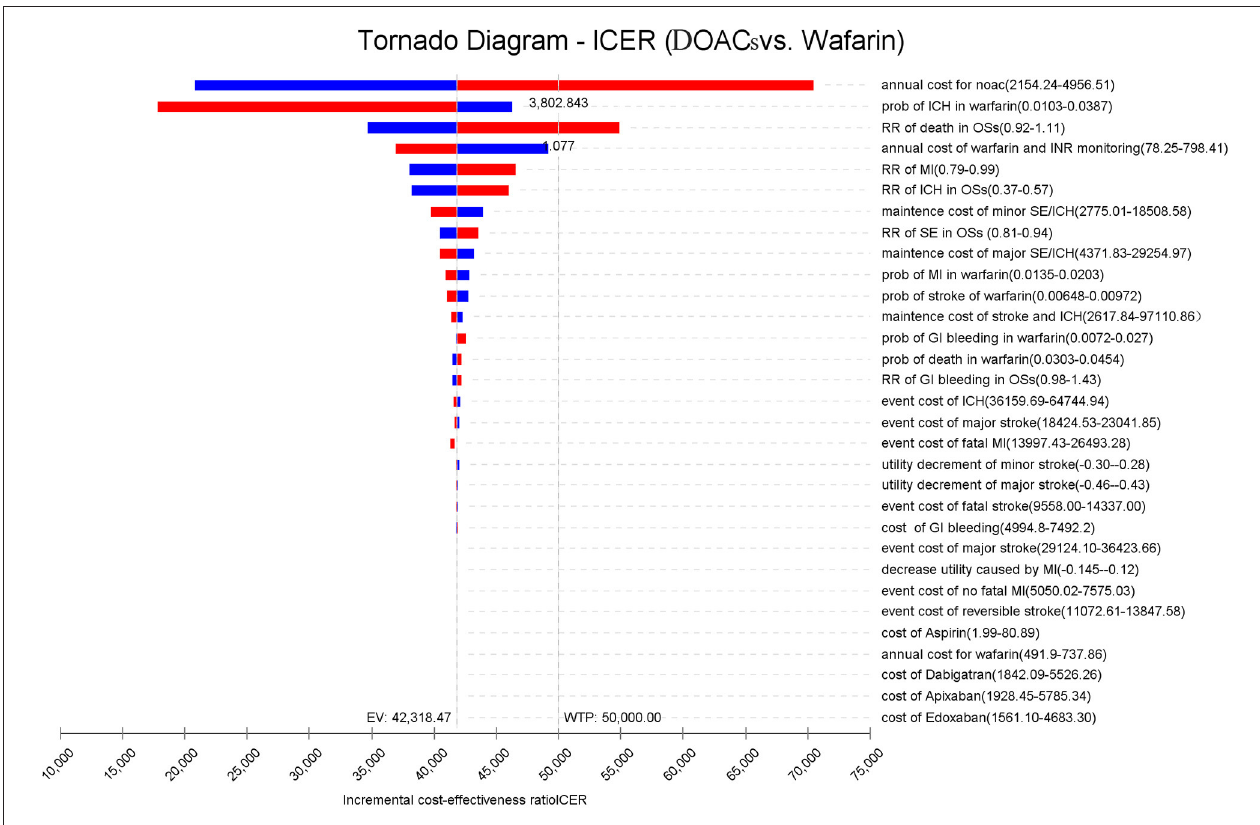
FIGURE 2 | Scenario analysis on the cost of DOACs (Dabigatran, Rivaroxaban, Apixaban, and